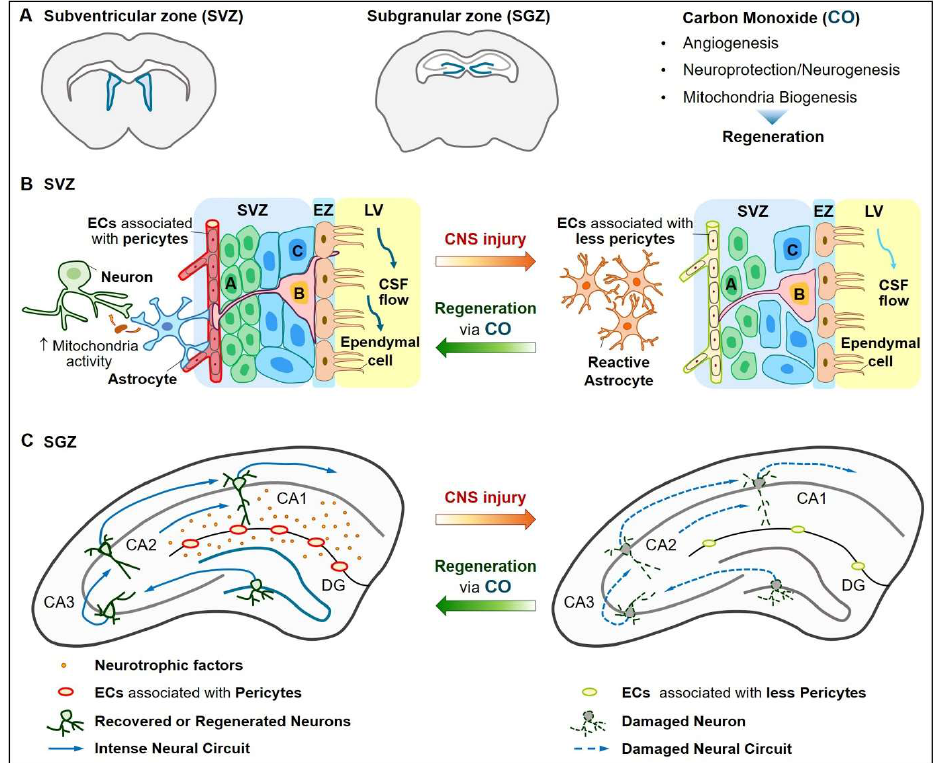
Figure 3. Schematic figures showing possible regenerative roles of CO in the adult neurovascular